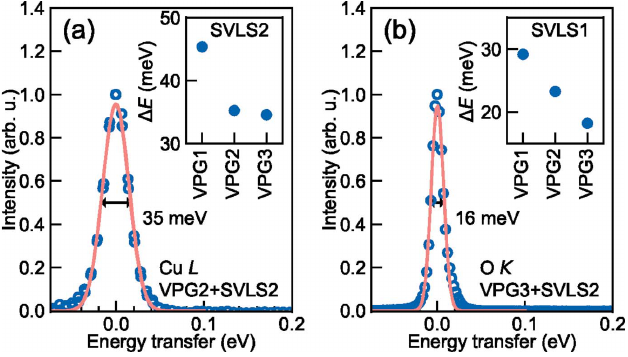
Figure 4 Elastically scattered X-ray beam at ( a ) Cu L - and ( b ) O K -edges from a carbon tape, fitted with Gaussian line-shapes of FWHM 35 and 16 meV, respectively. Insets show the achievable energy resolution at I21 for the three PGM gratings VPG1 (600 l/mm), VPG2 (1000 l/mm) and VPG3 (2000 l/mm) in combination with SGM gratings SVLS1 (1500 l/mm) and SVLS2 (2700 l/mm) at Cu L - and O K -edges.